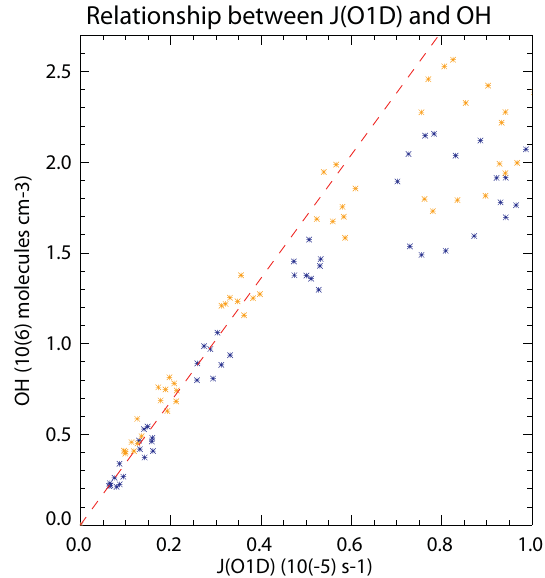
Fig. 4. The relationship between monthly mean J the surface concentration of OH (in molecules cm − 3 ) for the years 2004 through to 2007 for the BA (blue) and MBA (yellow). The red line represents the approximate fit to measurements taken at Hohen- peissenberg (Rohrer and Berresheim,